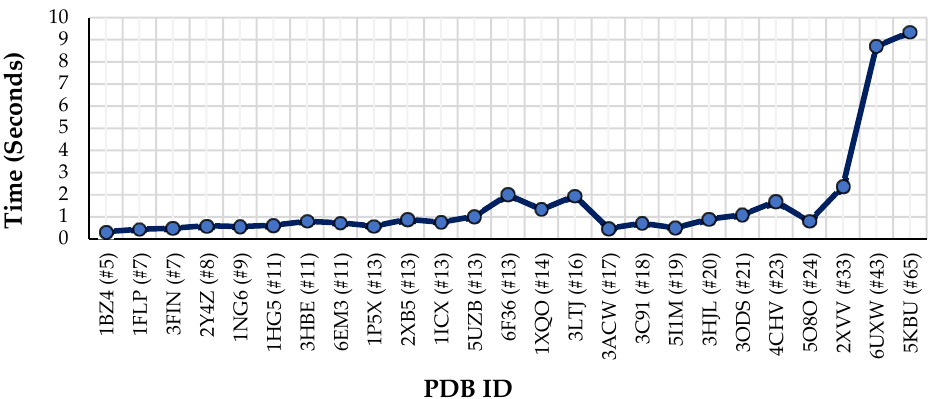
Figure 6. The runtime of the method with respect to the number of SSEs-A in proteins. (PDB ID (#SSEs-A)).